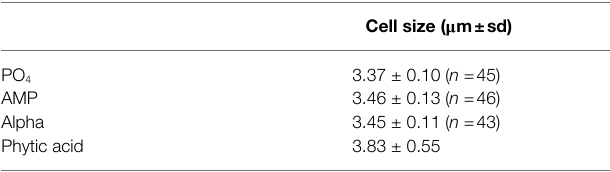
TABLE 1 | Average cell sizes and their respective standard deviation measured in exponentially growing cultures of Crocosphaera watsonii provided with either an inorganic (KH 2 PO 4 ) or organic [mono phosphate adenosin (AMP), DL- α - glycerophosphate (Alpha) or phytic acid] source of phosphorus for growth.